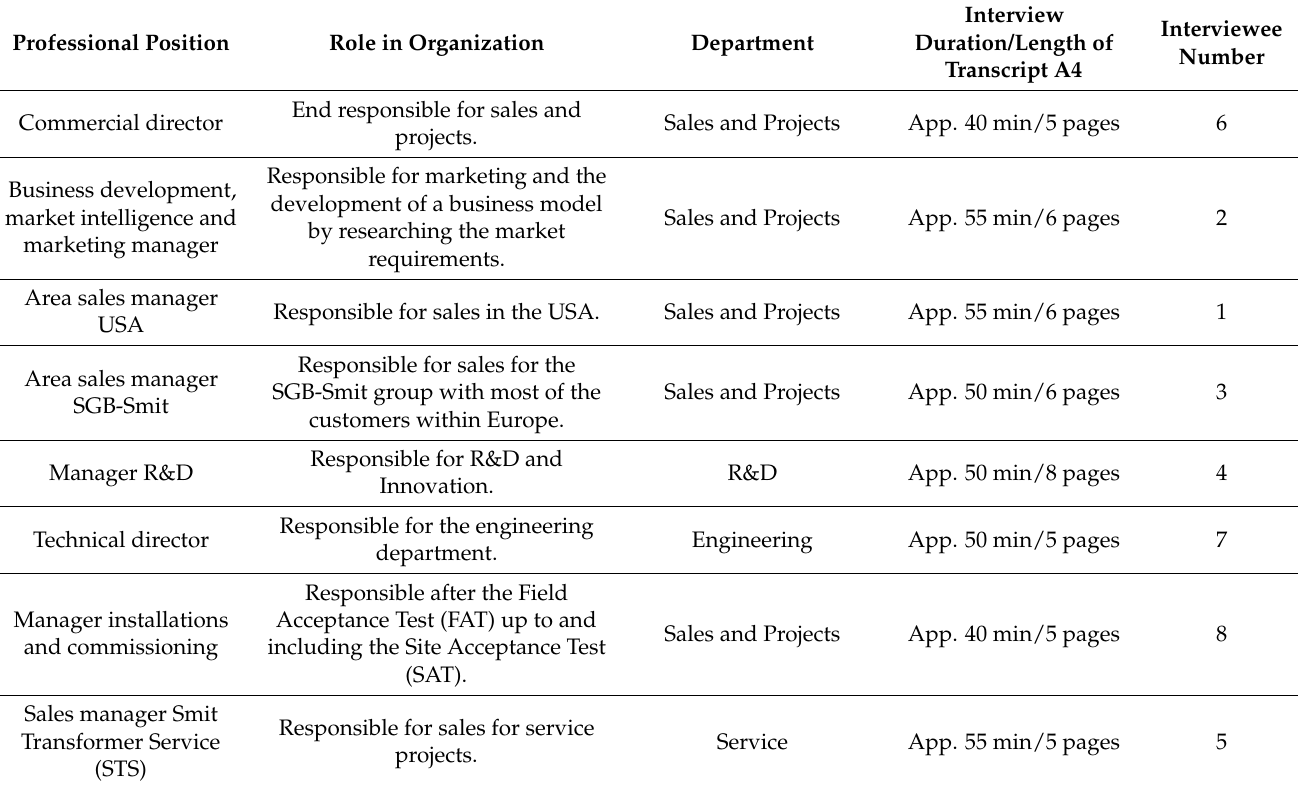
Table 2. Overview of respondents.